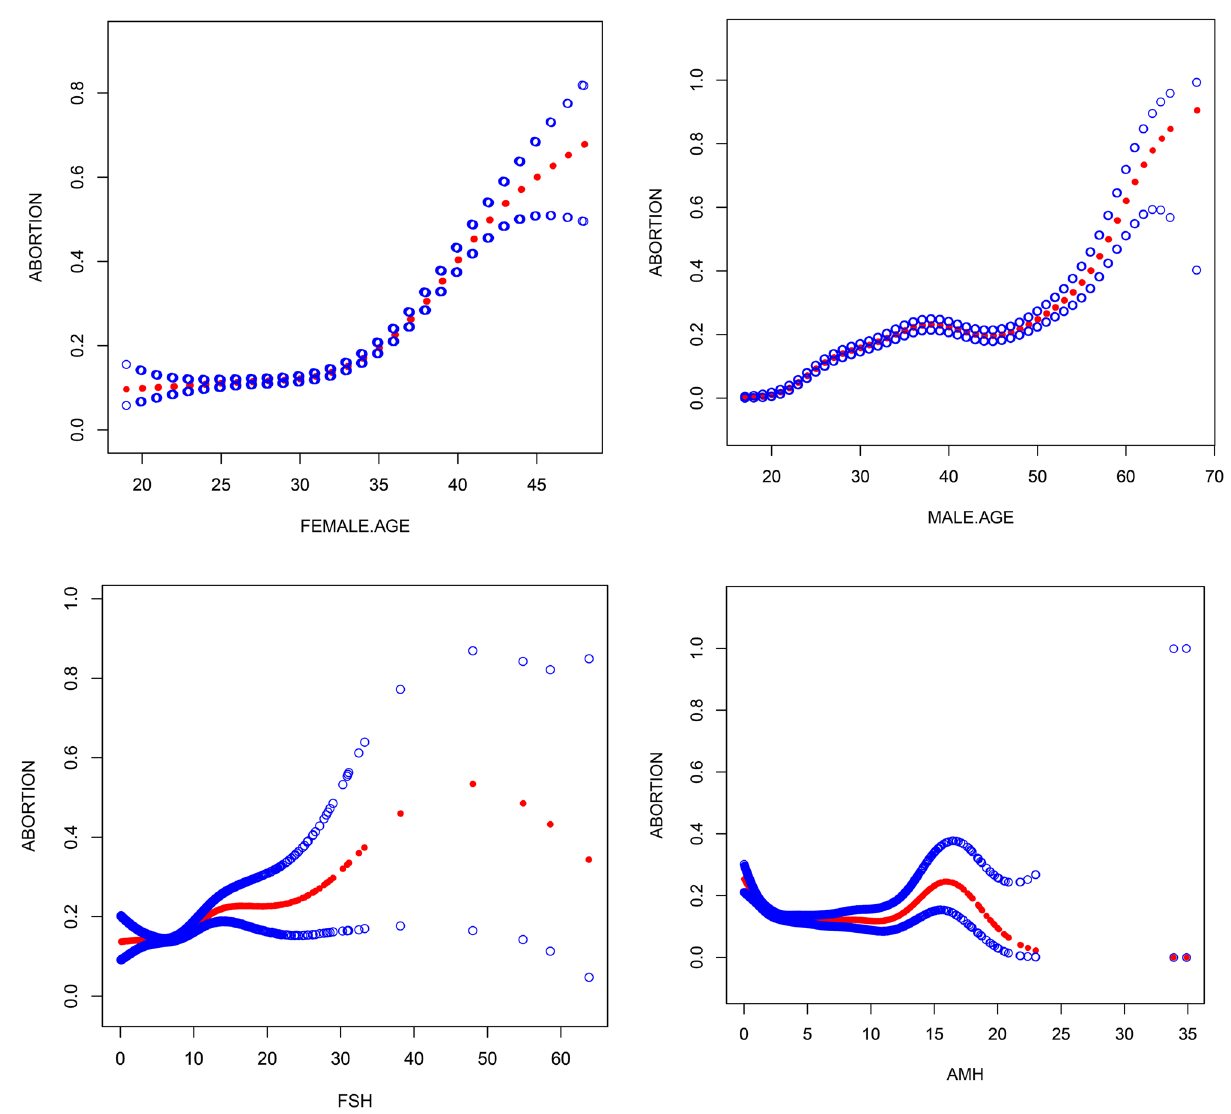
Figure 1. Association between spontaneous abortion and Female age, male age, basal FSH and AMH. A threshold, nonlinear association between spontaneous abortion and these independent predictive factors was found in a generalized additive model(GAM). Solid rad line represents the smooth curve fit between variables. Blue bands represent the 95% of confidence interval from the fit. Pregnancy outcome was defined as live birth rate, Gn,